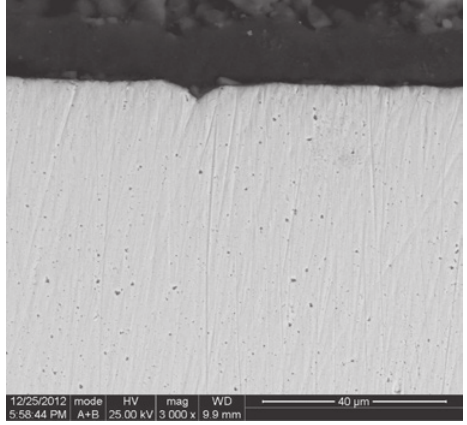
Table 3: Fitting results of electrochemical impedance spectra for the corrosion of pure nickel in molten (Li,Na,K)F at 973 K